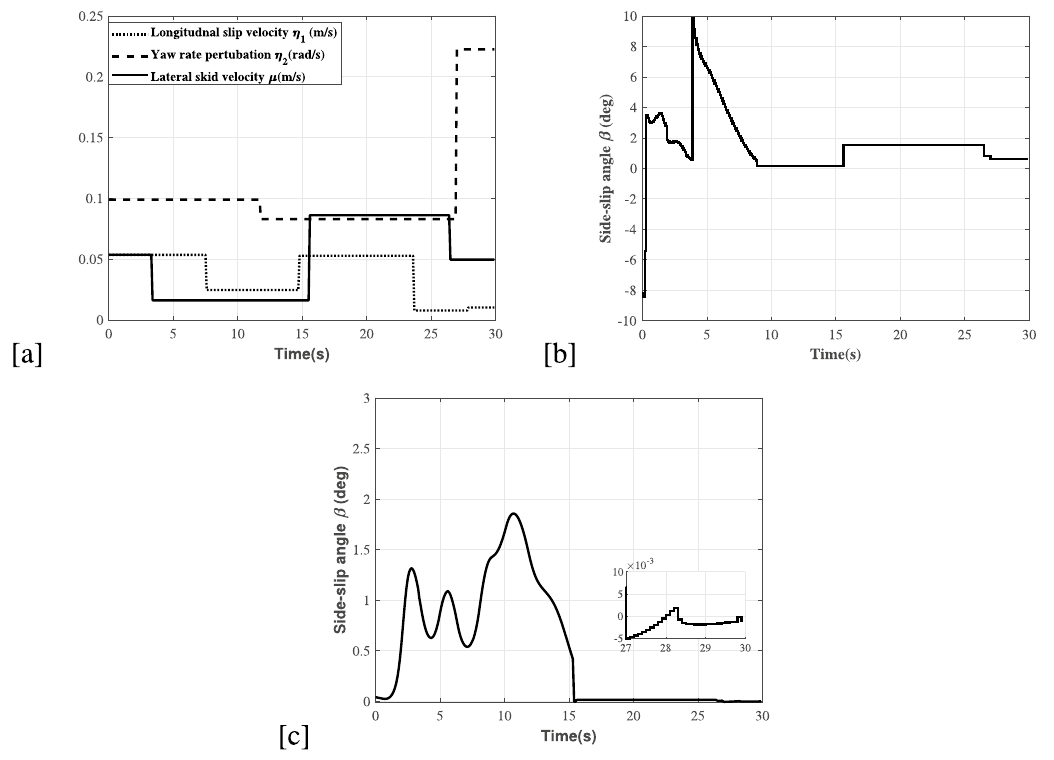
Figure 7. ( a ) PWL function-based slippage and skidding velocities. ( b ) Side slip angle of the front wheels for the simulation 1. ( c ) Side slip angle of the front wheels for the simulation